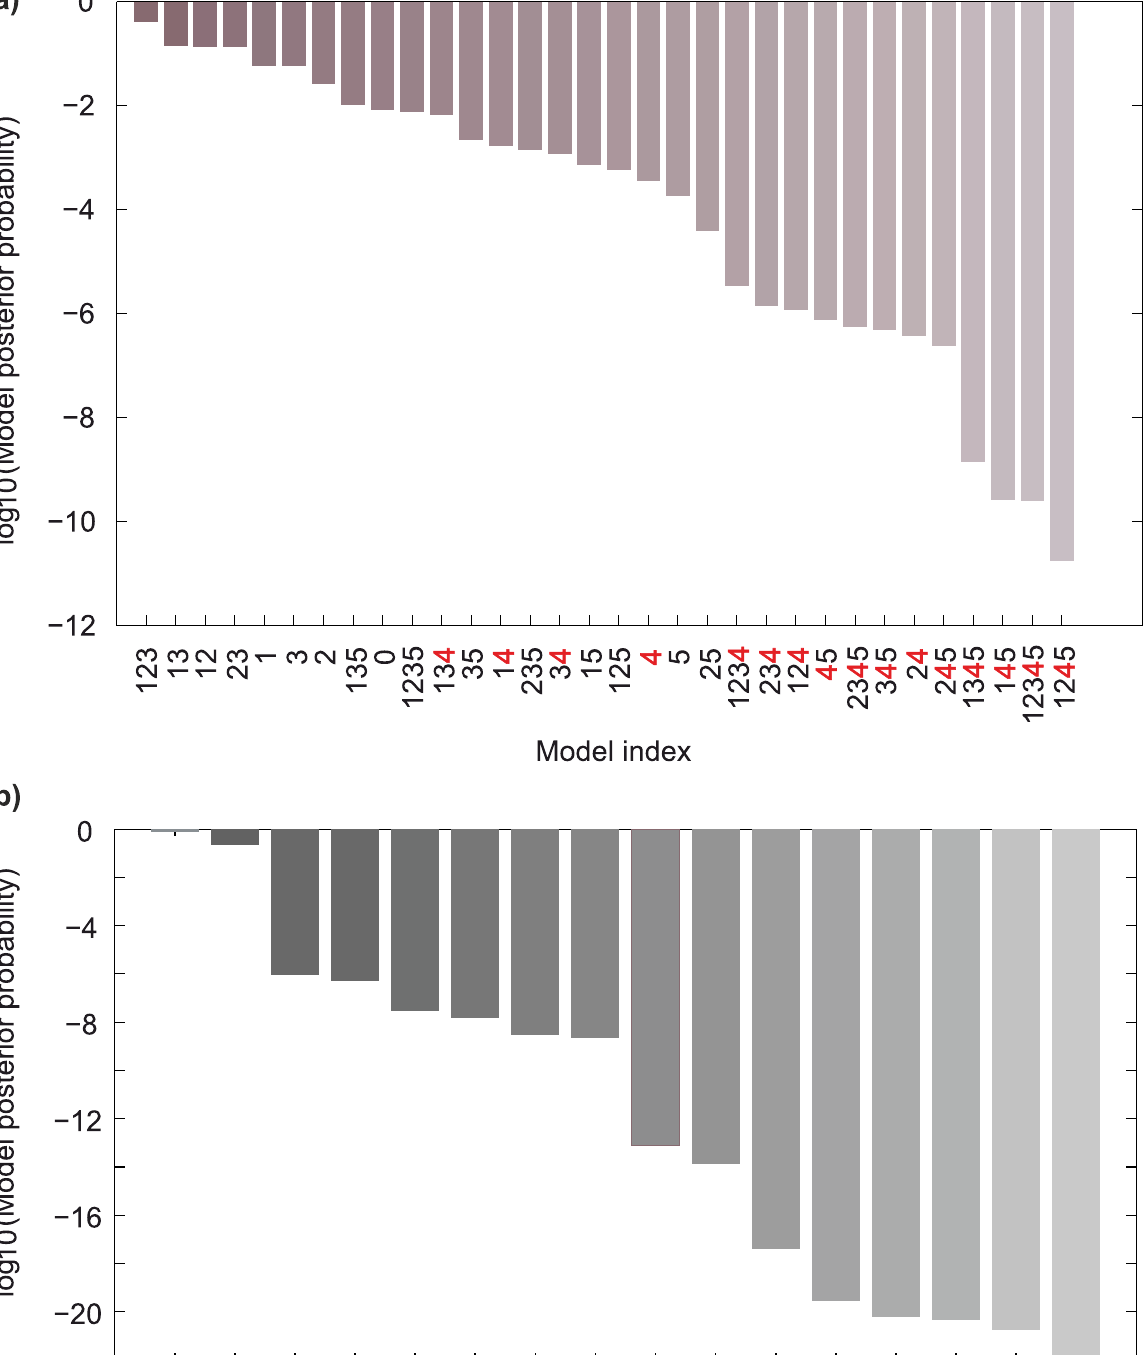
PLOS Computational Biology | DOI:10.1371/journal.pcbi.1004784 March 11,